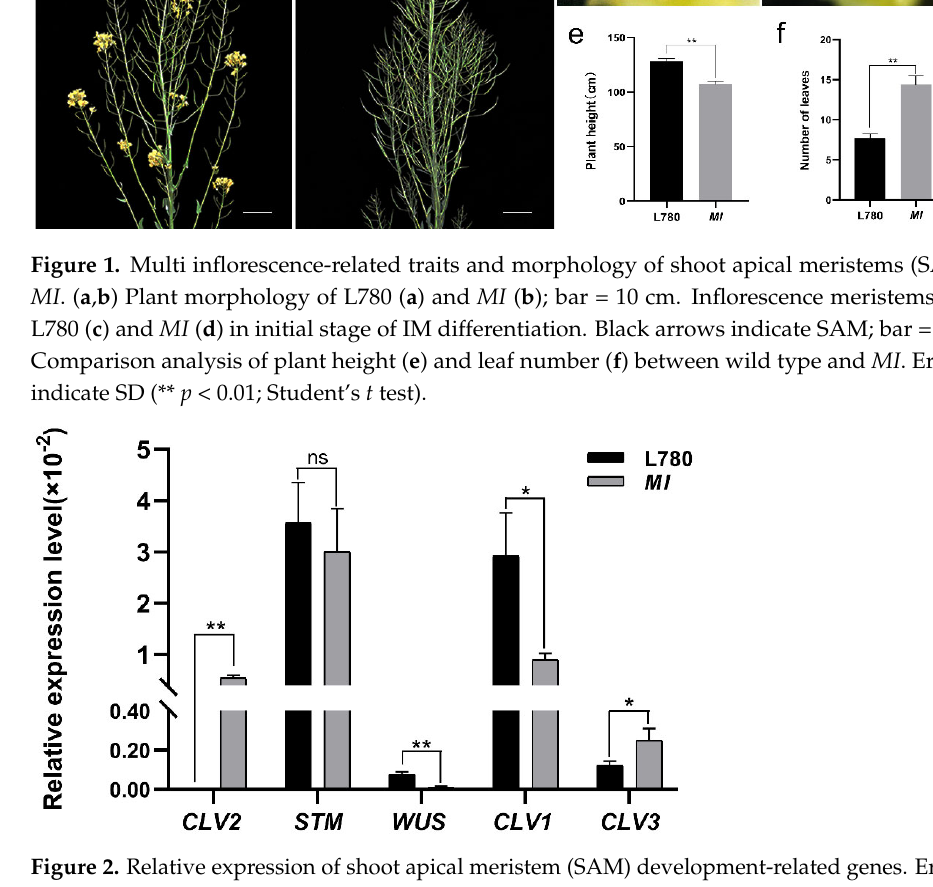
Figure 2. Relative expression of shoot apical meristem (SAM) development-related genes. Error bars indicate SD (* p < 0.05, ** p < 0.01, ns indicated no significant difference; Student’s t test).